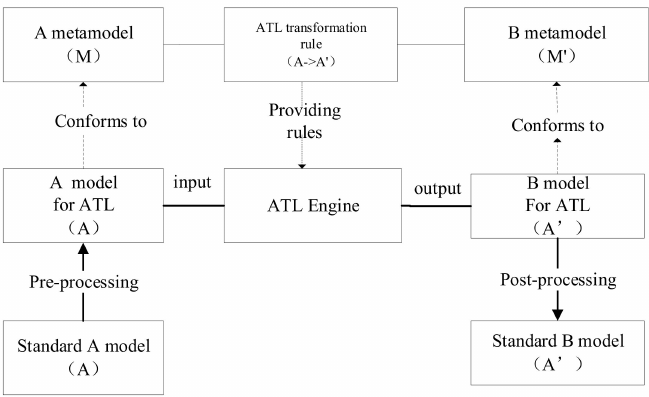
Figure 4. The method of model